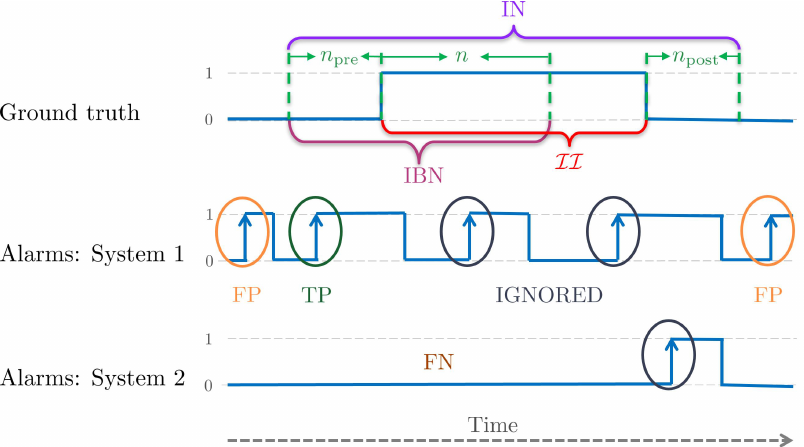
Figure 8. The top subfigure is the illustration of the definitions of edge-level evaluation terms on ground truth, with time in abscissa and non-intrusion (0) and intrusion (1) class for each frame of the video in ordinate. The next two subfigures represent examples of alarms and possible outcomes (TP, FP, FN) for two different PIDSs evaluated by the edge-level